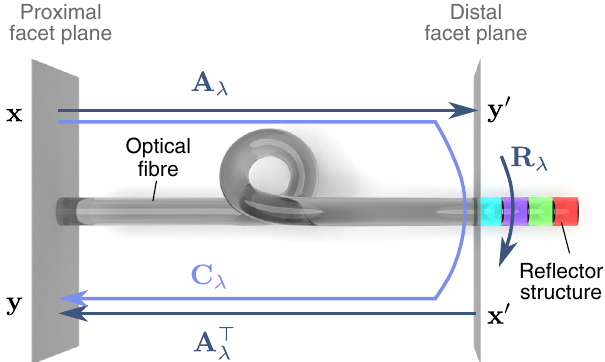
FIG. 1. Physical model used for fiber TM characterization in reflection mode. The proximal facet of the fiber is nearest to the imaging system (i.e., outside of the subject), while the distal facet is nearest the object being imaged (i.e., inside the subject). Vectors at the distal facet are denoted using the prime symbol ( 0 ). Here, A λ represents the fiber TM at wavelength λ , R λ the PM of the reflector stack, and C λ the round-trip RM, i.e., down the fiber, off the reflector, back up the